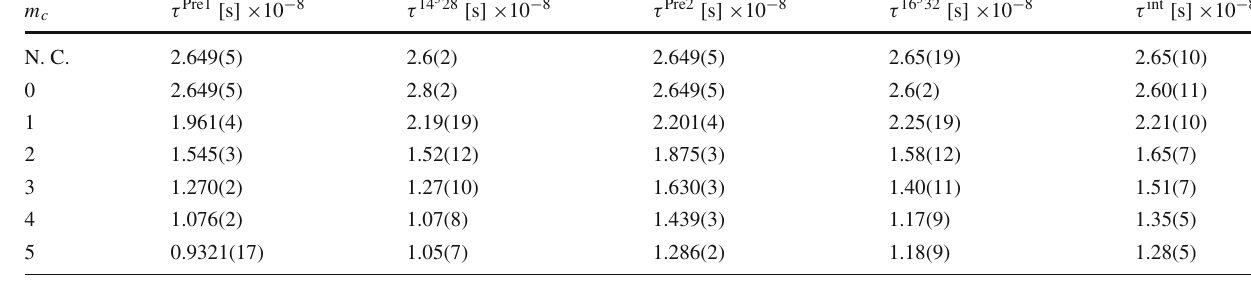
Table 27 Comparisons of the lifetimes τ 14 3 28 , τ 16 3 32 , and τ int with the predictions τ Pre1 and τ Pre2 . The outcomes of τ 14 3 28 , τ 16 3 32 , and τ int calculated using the lattice V = 14 3 × 28, V = 16 3 × 32, and